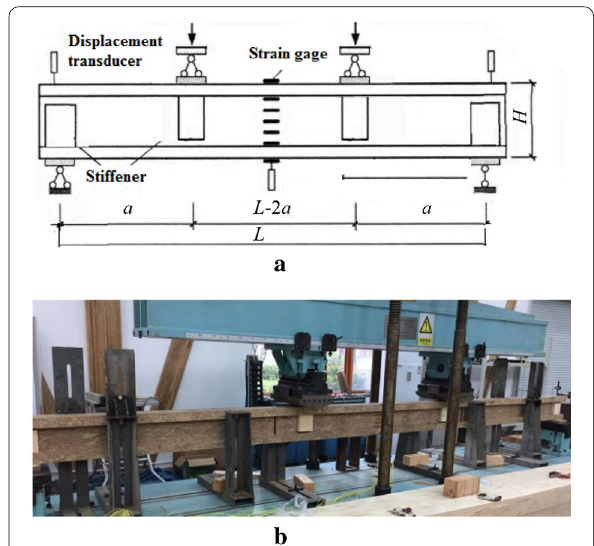
Fig. 3 The schematic drawing ( a ) and photos ( b ) of the bending test